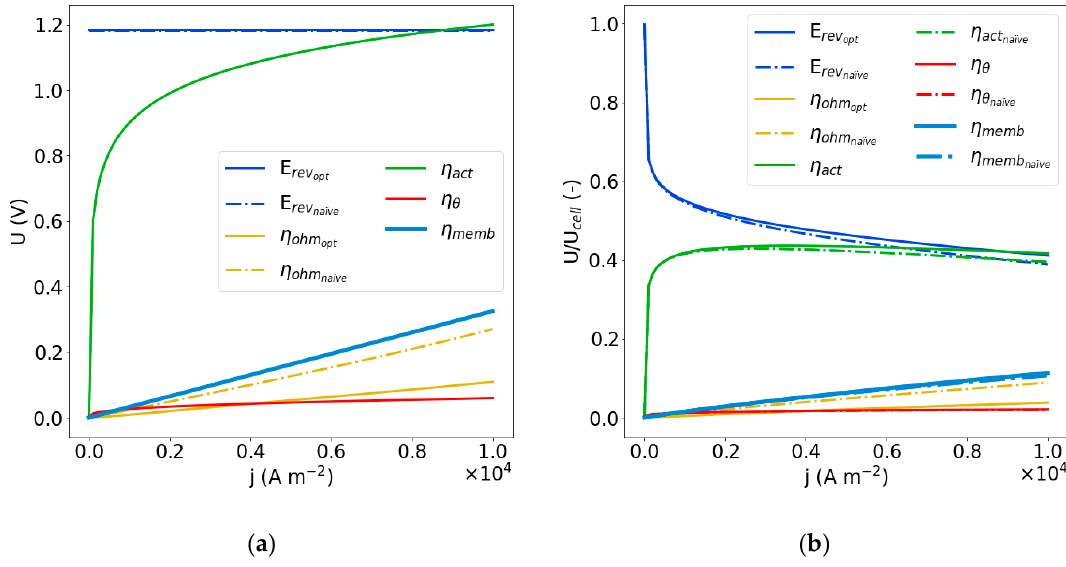
Figure 18. ( a ) Cell voltage of the naïve solution (dashed line) and optimum solution (solid line) ( b ) proportion of the different voltage of the cell voltage depending on the current density. The other overpotential are the same because they only are depending on the